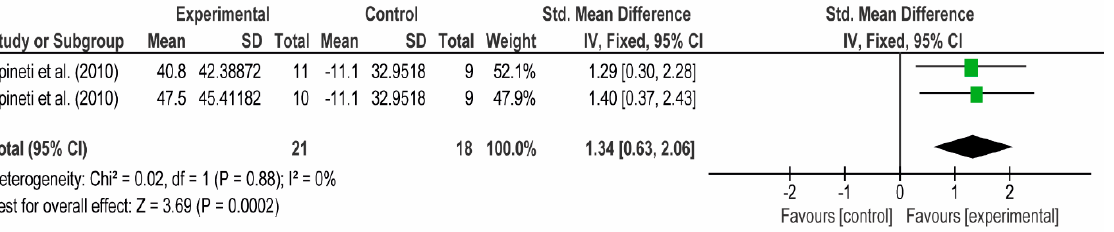
Figure 20. The effect size of 12-weeks of nonlinear periodised resistance training on increasing the Figure 20. The effect size of 12 -weeks of nonlinear periodised resistance training on increasing the Figure 20. The effect size of 12 -weeks of nonlinear periodised resistance training on increasing the Figure 20. The effect size of 12 -weeks of nonlinear periodised resistance training on increasing the biceps brachii MV. The lines for Spineti et al. [89] respectively represent nonlinear periodised large to biceps brachii MV. The lines for Spineti et al. [89] respectively represent nonlinear periodised large biceps brachii MV. The lines for Spineti et al. [89] respectively represent nonlinear periodised large biceps brachii MV. The lines for Spineti et al. [89] respectively represent nonlinear periodised large to small muscle training and small to large muscle training groups. small muscle training and small to large muscle training groups. to small muscle training and small to large muscle training groups. to small muscle training and small to large muscle training groups.